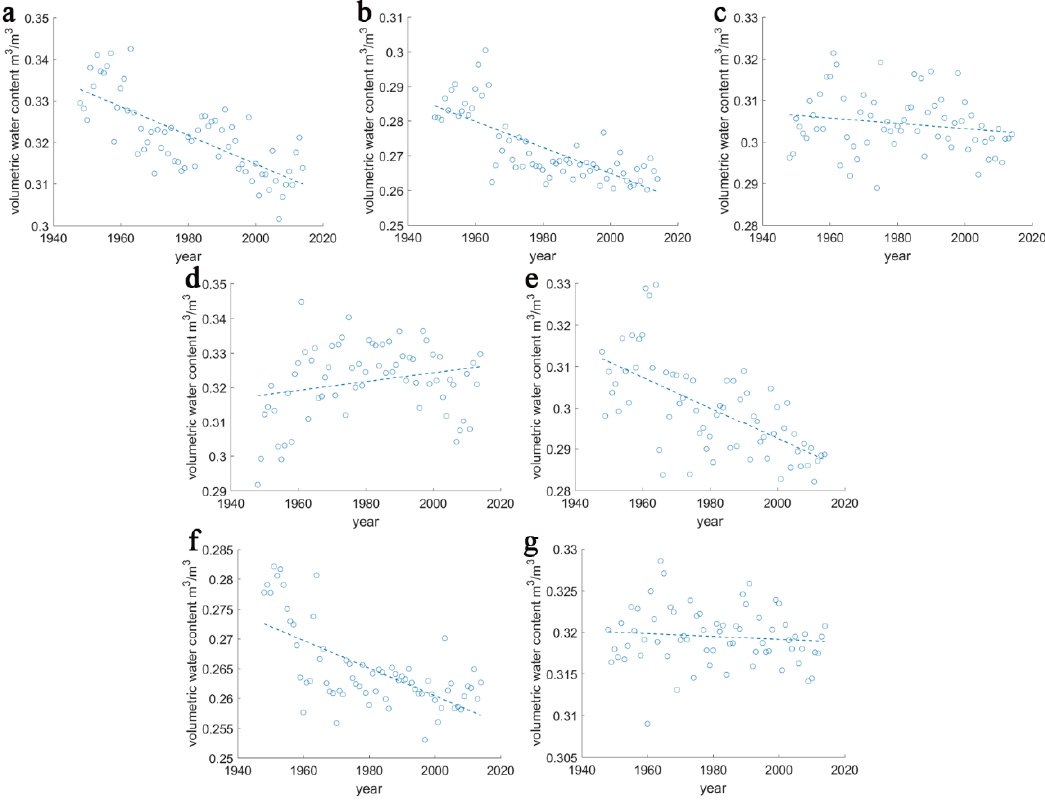
Figure 4. Interannual variation of soil moisture for 1948 to 2014 in the seven regions of China. ( a ) Northeastern China (NEC); ( b ) northern China (NC); ( c ) eastern China (EC); ( d ) southern China (SC); ( e ) central China (CC); ( f ) northwestern China (NWC); ( g ) southwestern China (SWC). Table 1. Soil moisture variation in di ff erent regions of China.